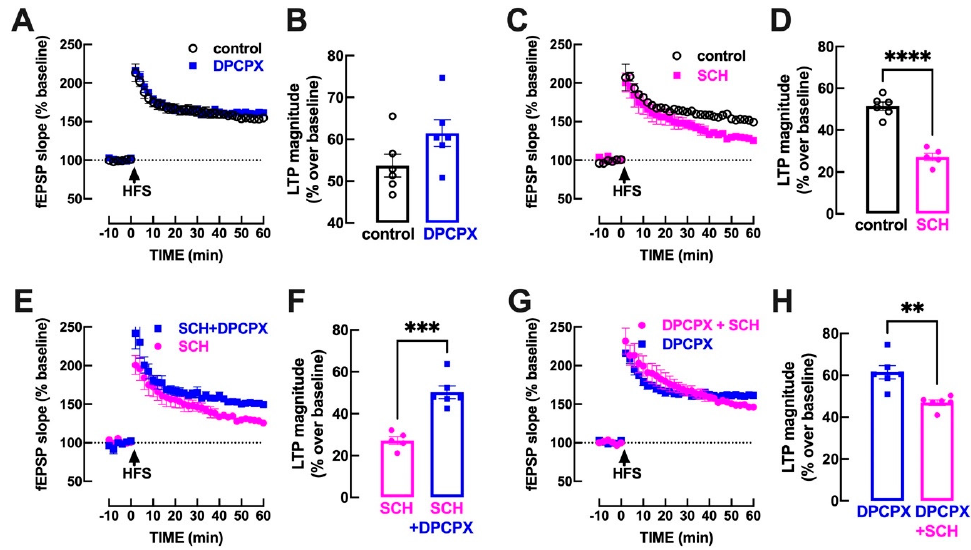
Figure 2. The tonic activation of A 2A R blunts the impact of the tonic activation of A 1 R to modify hippocampal long-term potentiation (LTP). A supramaximal concentration of the A 1 R antagonist DPCPX (50 nM) did not signi fi cantly modify the amplitude of long-term potentiation (LTP) of fi eld excitatory postsynaptic potentials (fEPSP) in Scha ff er fi bers-CA1 pyramid synapses of mouse hippocampal slices: the time course of fEPSP slope recordings ( A ) shows a sustained increase in fEPSP slope after delivering a high-frequency stimulation train (HFS: one train of 100 pulses at 100 Hz), which is not signi fi cantly di ff erent in the presence of 50 nM DPCPX (blue symbols) compared to its absence (black symbols), as quanti fi ed in ( B ). In contrast, the A 2A R antagonist SCH58261 (50 nM) signi fi cantly decreased LTP magnitude ( C , D ). In the continuous presence of SCH58261 (50 nM), DPCPX (50 nM) was now able to signi fi cantly increase LTP amplitude ( E , F ). In contrast, in the continuous presence of 50 nM DPCPX, SCH58261 (50 nM) was still able to decrease LTP magnitude ( G , H ), albeit causing an inhibition lower than in the absence of DPCPX ( D ). Data are mean ± S.E.M. of 5–6. ** p < 0.01, *** p < 0.005, **** p < 0.001, Student’s t test. 3.3. A 2A R Activation Dampens A 1 R-Mediated Inhibition of Hippocampal Transmission In contrast to the previously described ability of the tonic activation of A 2A R to control LTP and the modulation by A 1 R of LTP, SCH58261 (50 nM) was devoid of e ff ects on basal synaptic transmission ( − 1.35 ± 1.49% variation of baseline fEPSP slope alone and 1.44 ± 1.60% in the presence of DPCPX, n = 5, p > 0.05, t -test vs. 0%) and did not modify the disinhibition of basal synaptic transmission caused by the blockade of A 1 R by 50 nM DPCPX (28.0 ± 7.0% variation of baseline fEPSP slope by DPCPX in the absence and 28.6 ± 6.6% in the presence of SCH58261, n = 5, p > 0.05, unpaired Student’s t test) (Figure 3A,B). However, the activation of A 2A R with a supramaximal concentration of the exogenously added A 2A R agonist, CGS21680 (30 nM; [37]), con fi rmed that A 2A R activation a tt enuates the ability of A 1 R to inhibit synaptic transmission. In fact, as shown in Figure 3C, the selective A 1 R agonist CPA (6–60 nM) inhibited basal synaptic transmission in a concentration-dependent manner, and this inhibitory e ff ect was a tt enuated in the presence of 30 nM CGS21680, which by itself did not signi fi cantly a ff ect basal synaptic transmission (8.0 ± 4.0% variation of baseline fEPSP slope, n = 4, p > 0.05, t -test vs. 0%). As depicted in Figure 3D, the EC 50 of CPA to inhibit basal synaptic transmission was 13.9 nM (95% con fi dence interval of 11.0–16.8 nM, n = 6) and it was shifted to the right in the presence of 30 nM CGS21680 (EC 50 = 34.8 nM, 95% con fi dence interval of 25.8–43.8 nM, n = 4). Notably, this e ff ect of CGS21680 on CPA-induced inhibition was eliminated in the presence of 50 nM SCH58261 (EC 50 = 15.3 nM, 95% con fi dence interval of 9.7–20.8 nM, n =